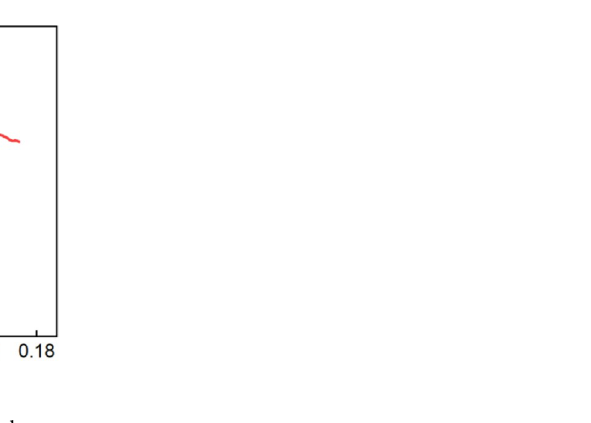
Figure 22. Stress–strain curves of test